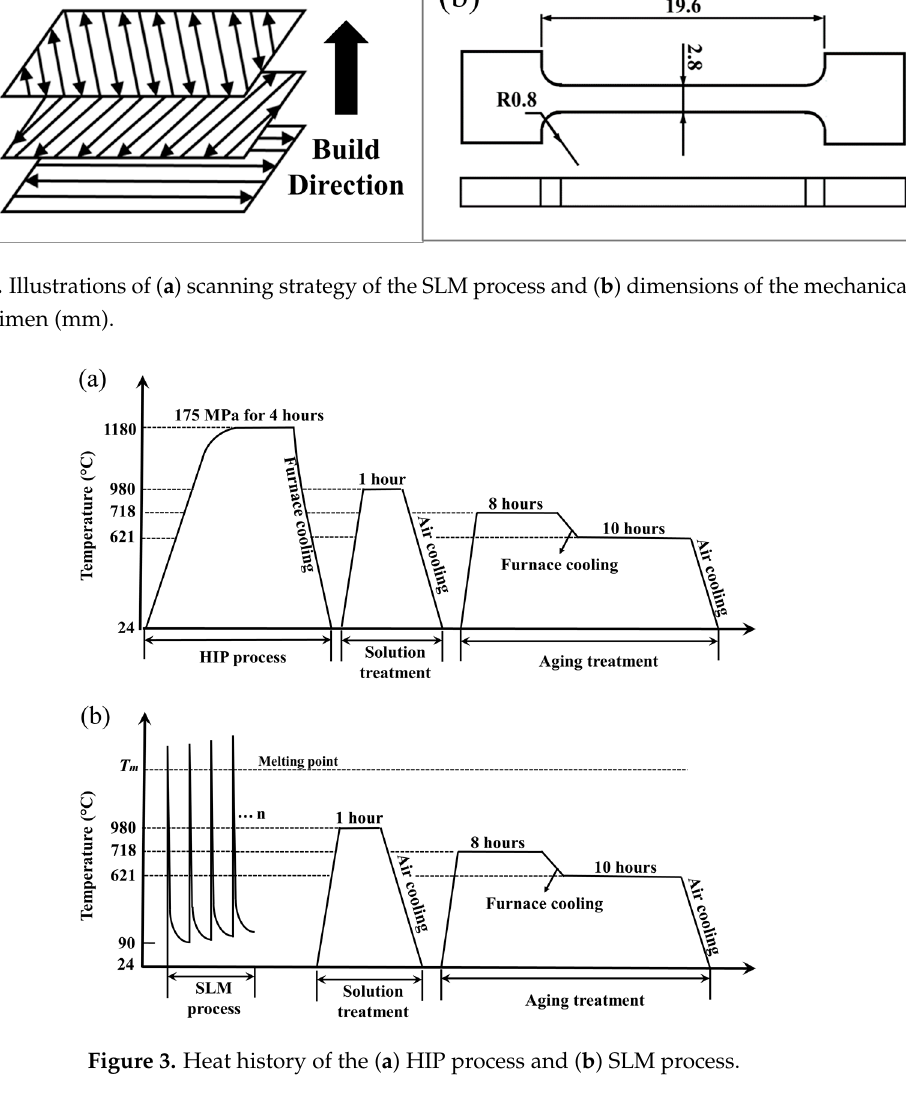
Figure 3. Heat history of the ( a ) HIP process and ( b ) SLM process.